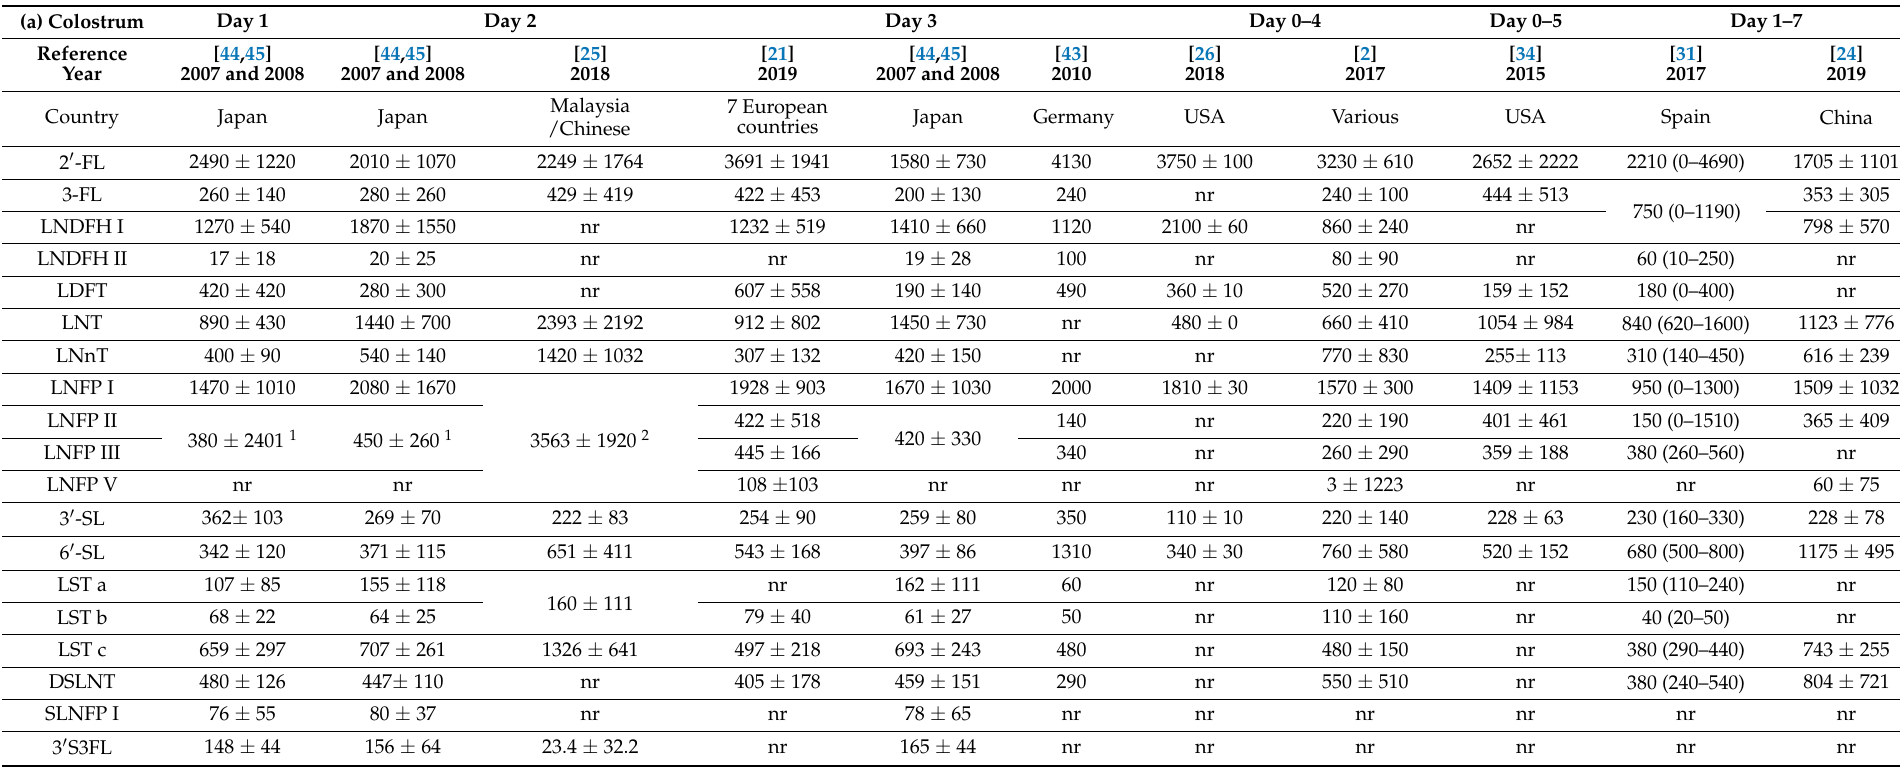
Table 4. Concentrations of the main individual HMOs in human (a) colostrum, (b) transitional, and (c) mature milk from mothers with either secretor positive, or unknown secretory status. The HMO concentrations (mg/L) are shown as mean ± standard deviation or mean